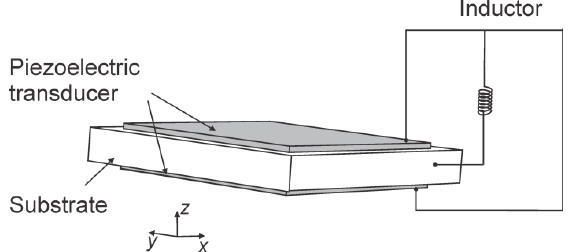
Figure 1. Unit-cell of piezoelectric metamaterial.